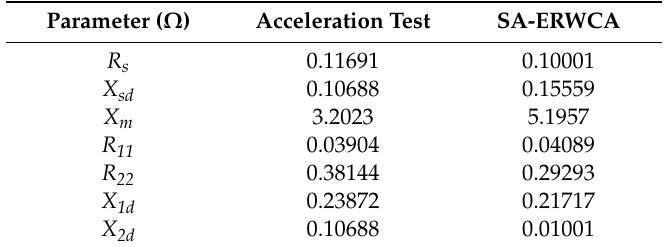
Table 15. Results for acceleration test and SA-ERWCA for Machine 3.